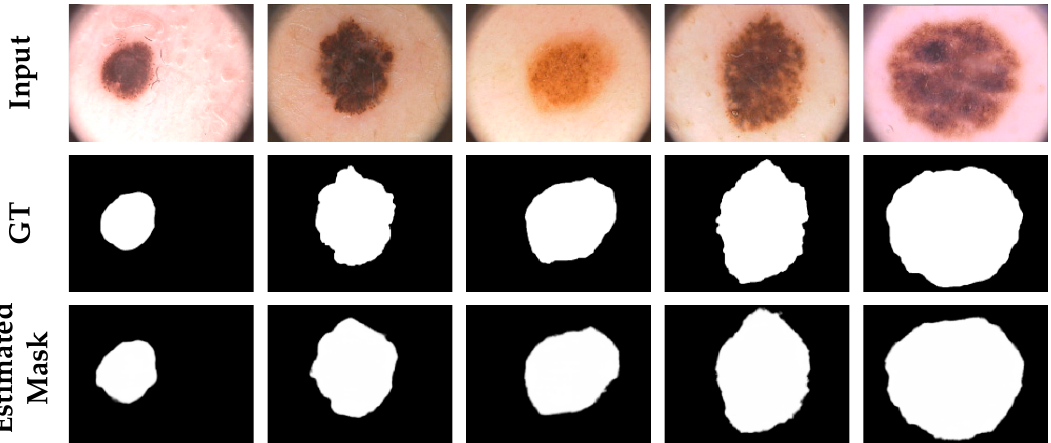
Table 4. Performance comparison of the proposed network and other methods on the PH2 dataset.